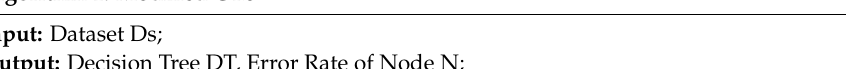
Algorithm 1. Modified